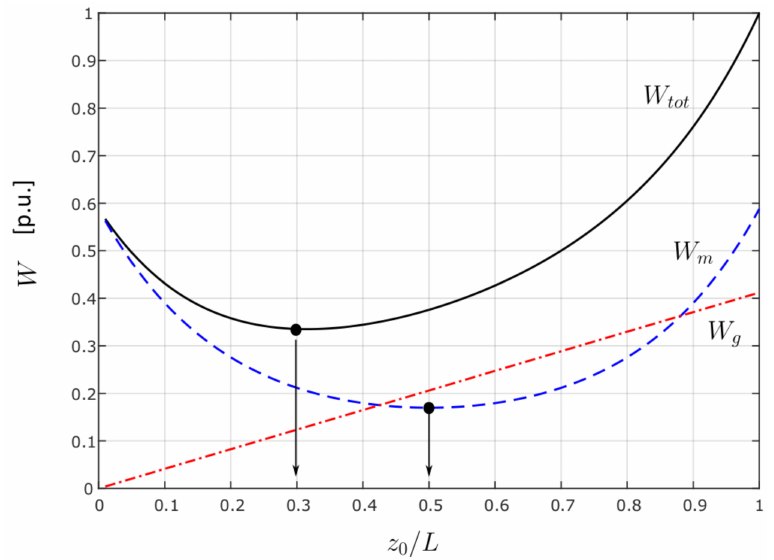
Figure 8. Results of a qualitative analysis based on the energy method. A stable levitation height is attained at the minimum of the total energy. The influence of the levitating object’s weight acts in the way to move the equilibrium height towards the lower value. Data used in the analysis are given as follows B p = 1.21 T, D = 10 mm, S 0 = 100 mm 2 , L = 40 mm, α = 64 m − 1 , µ = 1.17 µ 0 , a = 200 mm, and c = − 160 mm. Each of the curves are normalized by the maximum value of the total